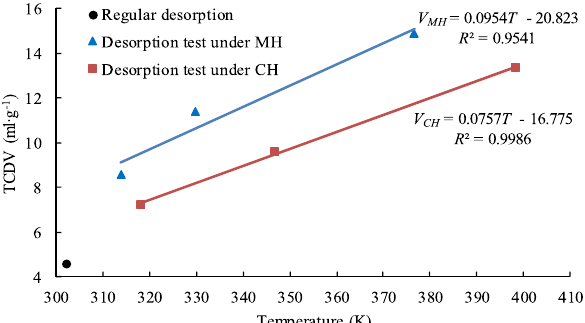
Figure 11. Linear relationship between TCDV and temperature. The lines and equations in the graph are the linear regressions fit to the TCDV values and the final temperatures shown in Fig. 9.